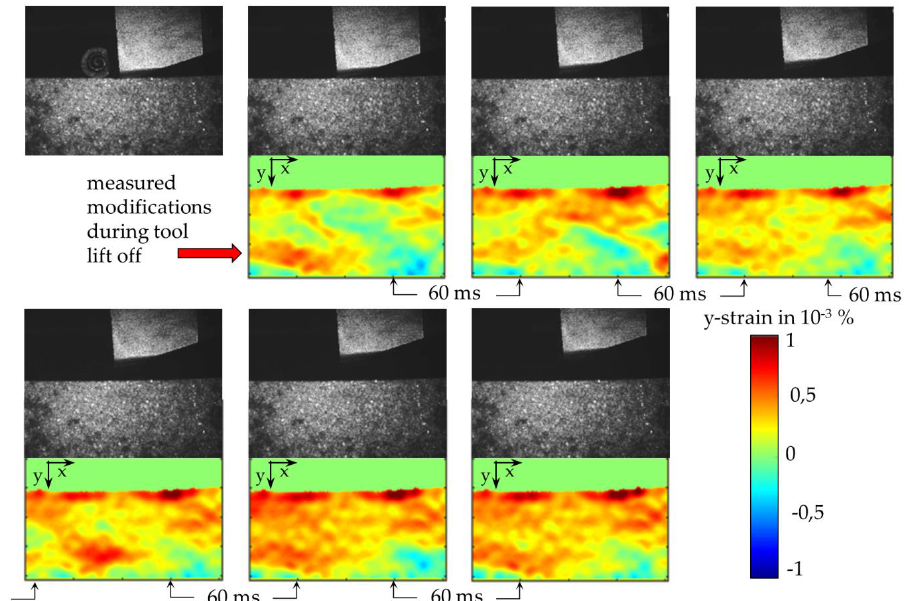
Figure 11. Image of the tool and the workpiece as well as the corresponding dynamic strain result after the last tool impact.